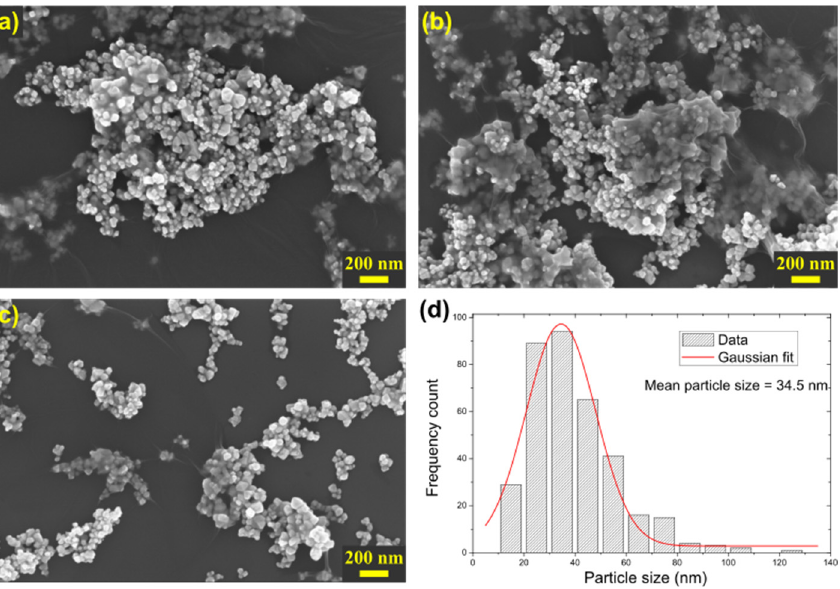
Figure 4. Scanning electron microscopy image of samples prepared with ( a ) 5, ( b ) 15, and ( c ) 50 v/v% of In 2 O 3 nominal compositions. ( d ) Particle size distribution and a Gaussian fit with an average particle size of 34.5 nm.